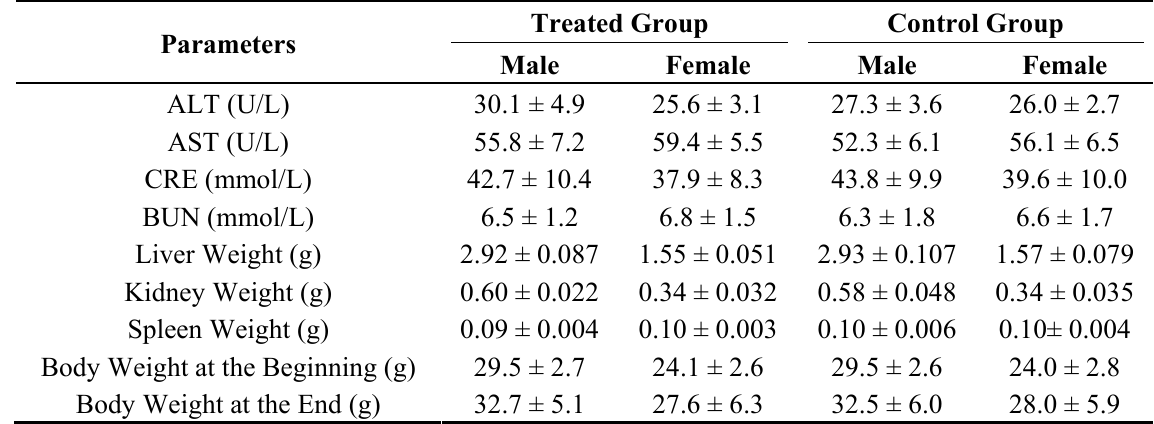
Table 2. Serum biochemical and organ weight data after acute toxicity